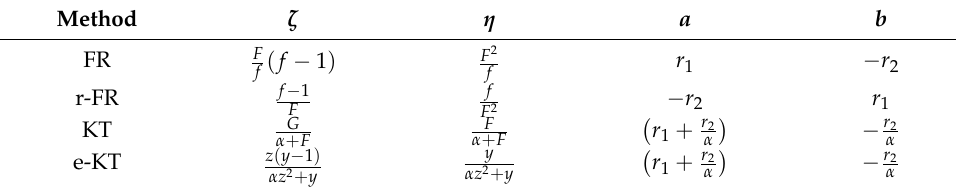
Table 1. The line parameters for the linear methods presented